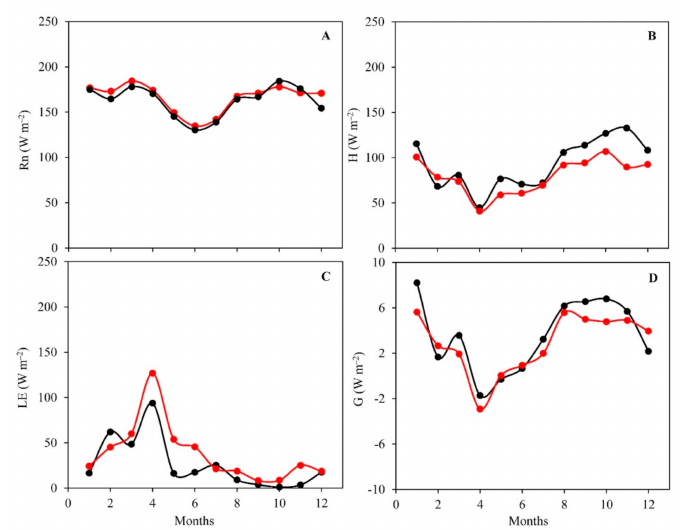
Figure 6. Simulations with calibration (solid red lines) for the wet season (simulation V) and dry season (simulation U) and eddy covariance observations (solid black lines) of monthly mean values of energy fluxes of 2015. Net radiation (Rn; ( A )), sensible heat flux (H; ( B )), latent heat flux (LE; ( C )) and soil heat flux (G; ( D )). For details on the calibrated parameters of simulations V